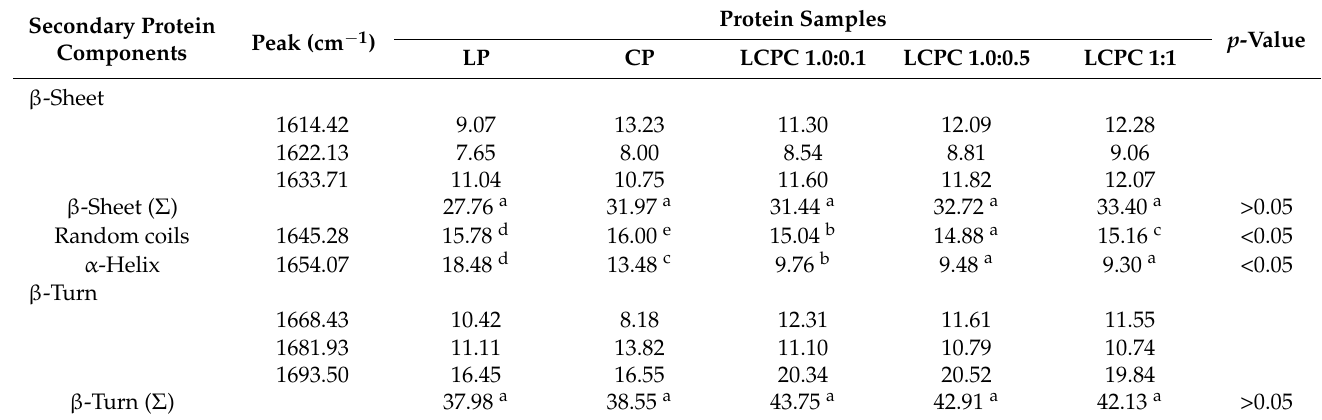
Table 1. Evaluation of the proportion of secondary protein components of lentil proteins (LP), casein proteins (CP) and lentil–casein protein complexes